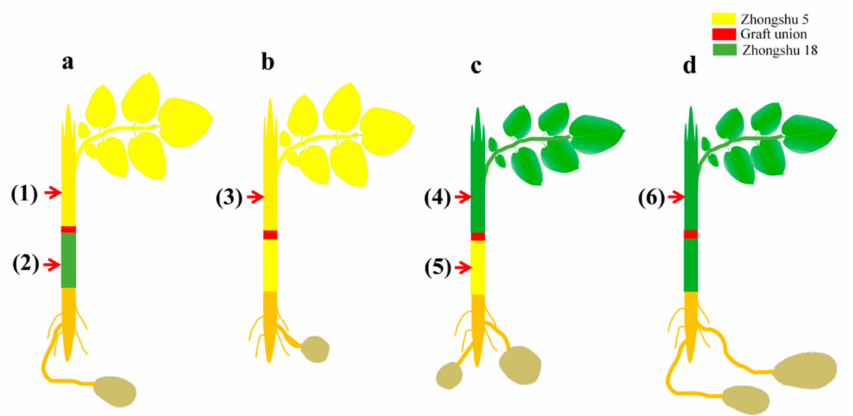
Figure 6. The sampling diagram of Zhongshu5 and Zhongshu18 mutual grafted and self-grafted plants: ( a ) Z5/Z18, early-maturing cultivar Z5 was grafted onto late-maturing cultivar Z18; ( b ) Z5/Z5, early-maturing cultivar Z5 was self-grafted; ( c ) Z18/Z5, late-maturing cultivar Z18 was grafted onto early-maturing cultivar Z5; ( d ) Z18/Z18, late-maturing cultivar Z18 was self-grafted. (1) and (2) were Z5/Z18-S (Zhongshu5 scion) and Z5/Z18-R (Zhongshu18 rootstock) stems, respectively; (3) was Z5/Z5 stems; (4) and (5) were Z18/Z5-S (Zhongshu18 scion) and Z18/Z5-R (Zhongshu5 rootstock) stems, respectively; (6) was Z18/Z18 stems. The red arrow indicates the sampling position at 5 cm from the graft